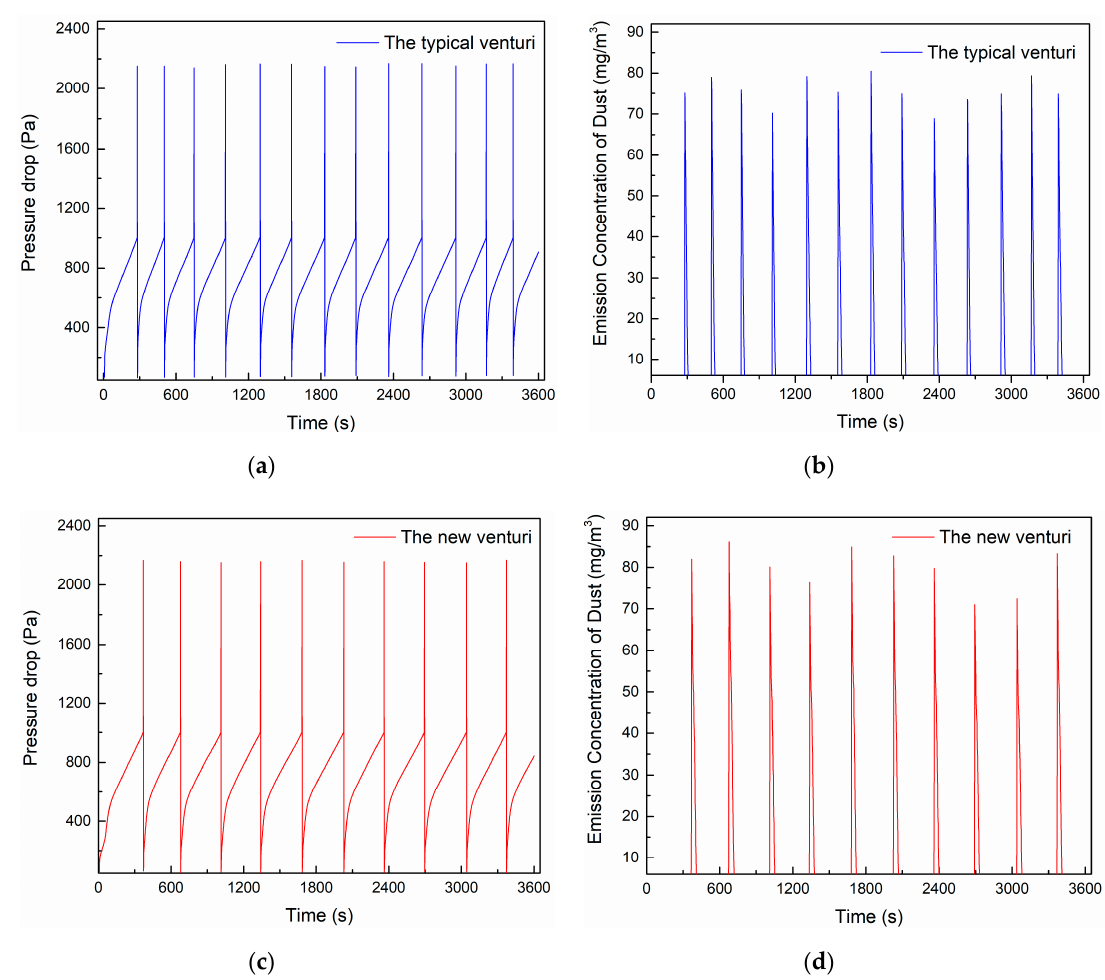
Figure 16. The variation of operating resistance and dust emission concentration of baghouses adapted with a typical venturi tube or a new venturi design. ( a ) The variation of operating resistance of baghouse with the typical venturi. ( b ) The variation of dust emission concentration of baghouse with the typical venturi. ( c ) The variation of operating resistance of baghouse with the new venturi. ( d ) The variation of dust emission concentration of baghouse with the new venturi.